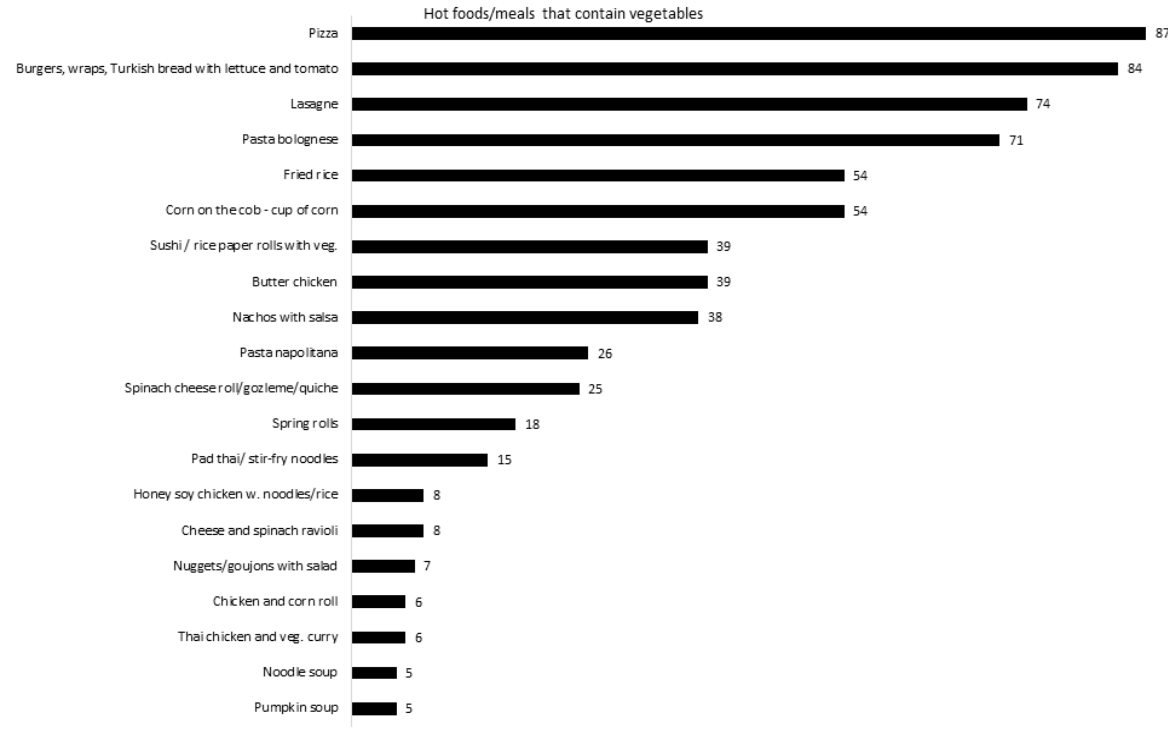
Figure 2. Hot foods/meals containing vegetables (the numbers represent the total number of menus that listed the item).